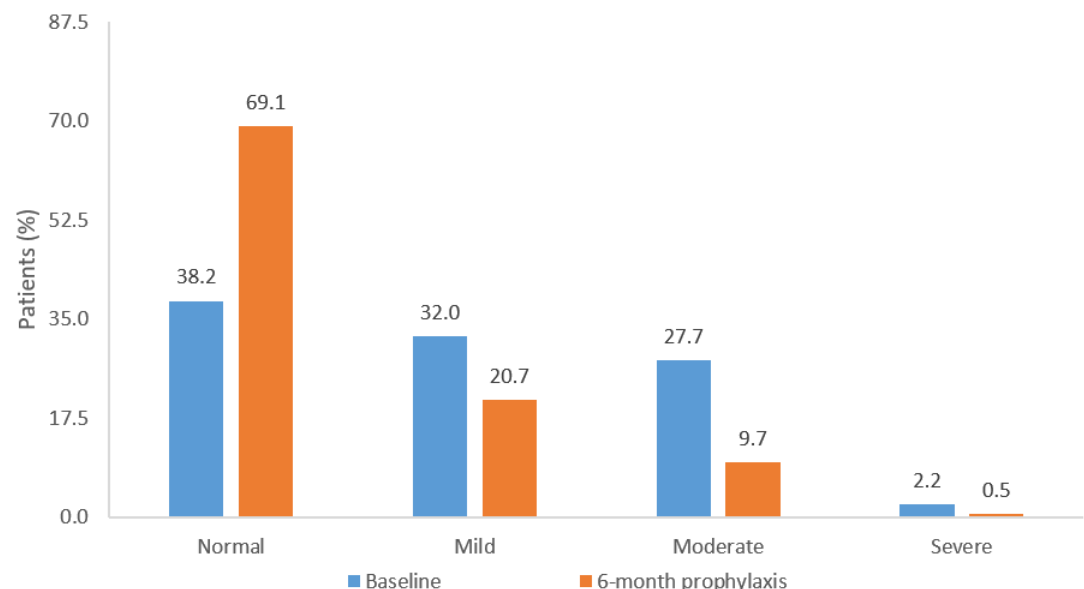
Figure 1: Proportion of recurrent UTI patients with normal to severe anxiety/depression according to Total Hospital Anxiety and Depression score at baseline and following six months of prophylaxis (principally with OM-89), analysis population N=575